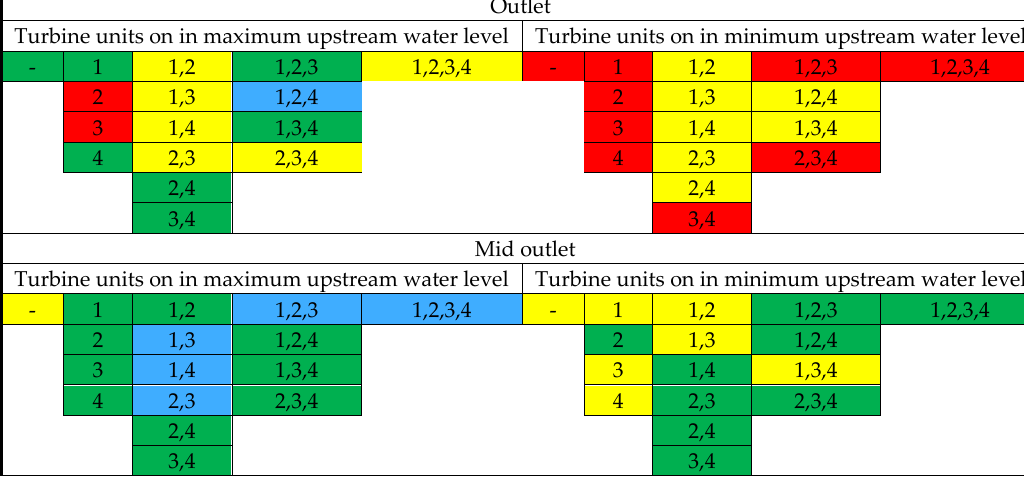
Figure 16. Control program for the running turbines inside the Temenggor powerhouse based on minimizing the principle